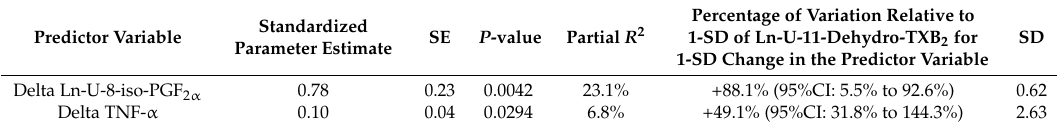
Table 5. Multivariable linear regression analysis for delta Ln- U-11-dehydro-TXB